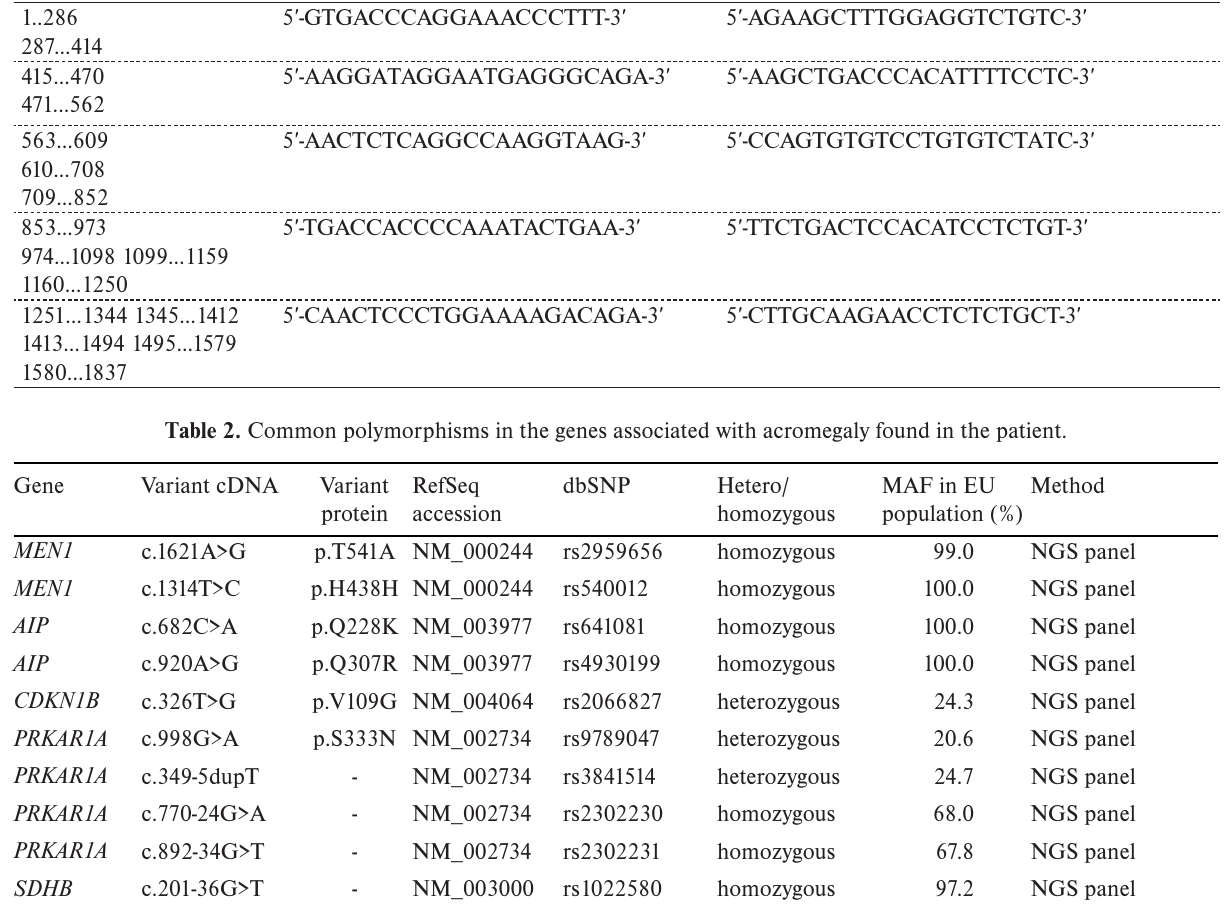
Table 1. Sequences of the specific primers used for PCR amplification of all 16 exons of the AAAS gene (NM_015665). Location of exons (NM_015665)